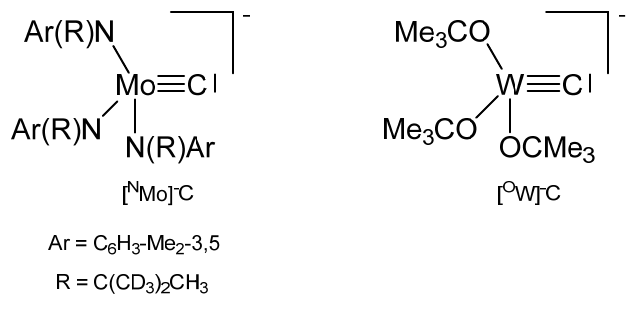
Figure 34. The [ N Mo] − C and [ O W] − C core.